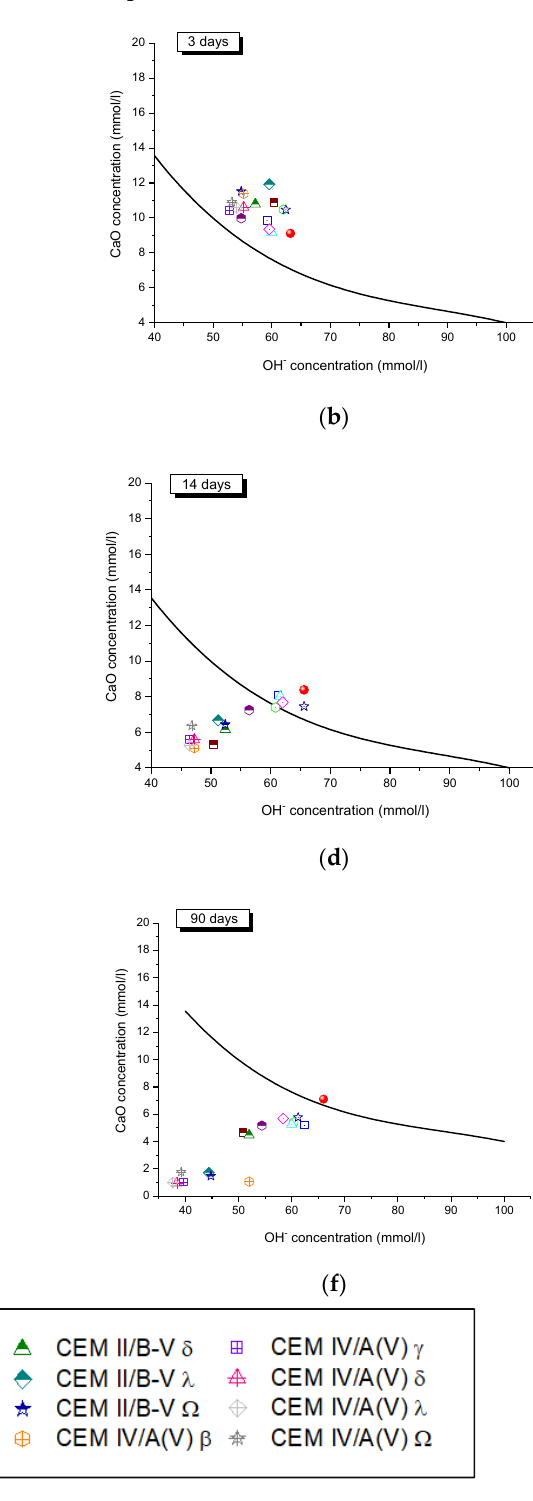
Figure 4. Pozzolanicity for all the mixes measured at several testing times (EN 196-5): ( a ) 1 day; ( b ) 3 days; ( c ) 7 days; ( d ) 14 days; ( e ) 28 days and ( f ) 90 days.